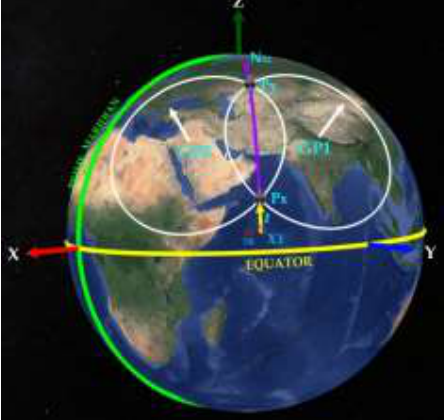
Figure 5. The concept of the closed analytical solution.